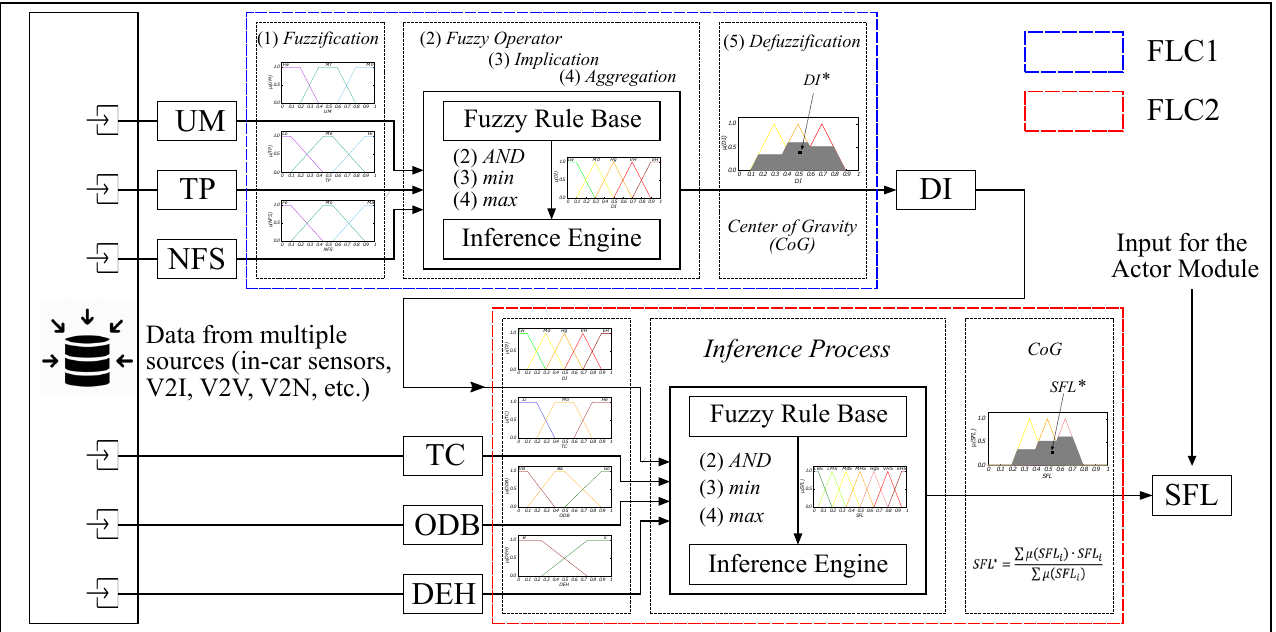
Figure 3. Detailed diagram of